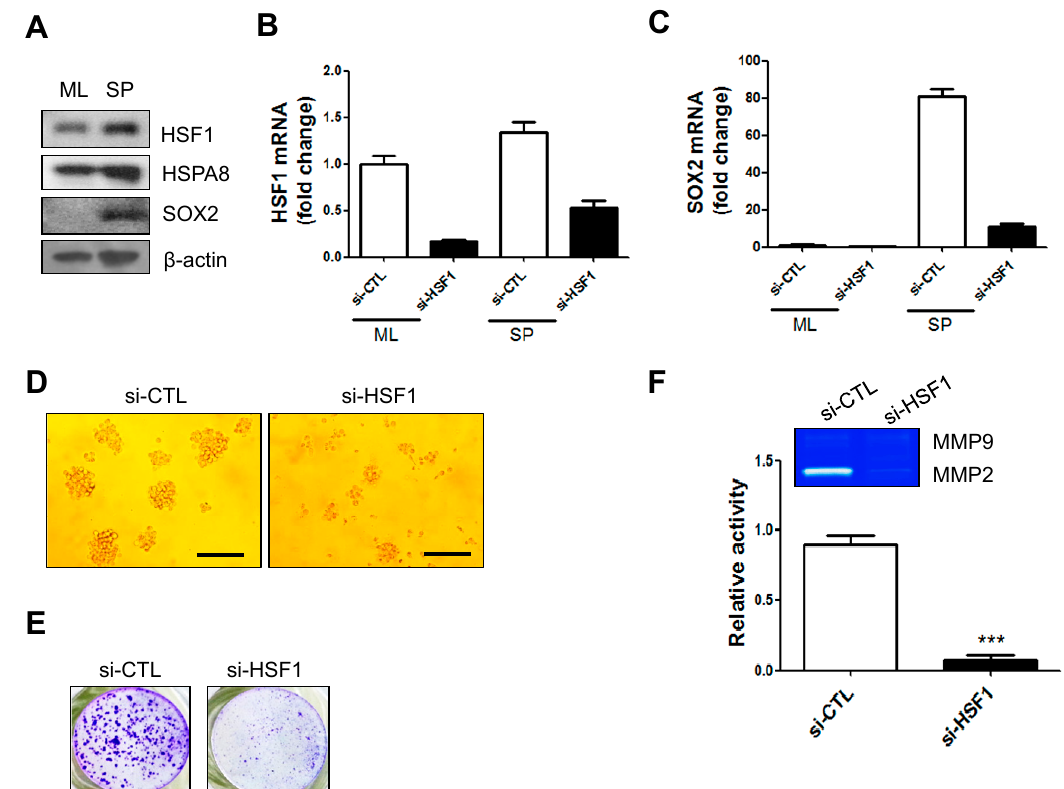
Figure 2. Protein and mRNA levels of HSF1 increased in SP-forming conditions and HSF1 depletion affected SP formation and MMP2 activity: ( A ) Western blot analysis of HSF1, HSPA8, and sex determining region Y (SRY)-box 2 (SOX2) in the ML and SP-forming conditions; ( B , C ) HSF1 and SOX2 mRNA levels in the ML or SP-forming conditions with or without HSF1 knockdown; ( D , E ) HSF1 depletion decreased SP formation. SPs were visualized by crystal violet staining. Scale bars: 200 µ m, 200 × ; ( F ) Metalloprotease (MMP)2 activity was analyzed by gelatin zymography. *** p < 0.005 vs. siCTL.